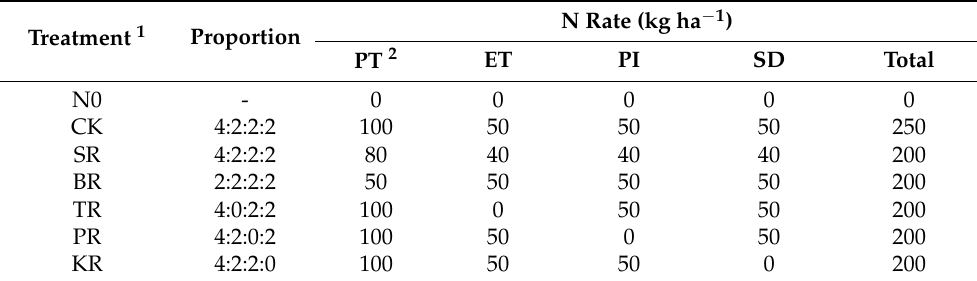
Table 1. Description of N reduction treatments.